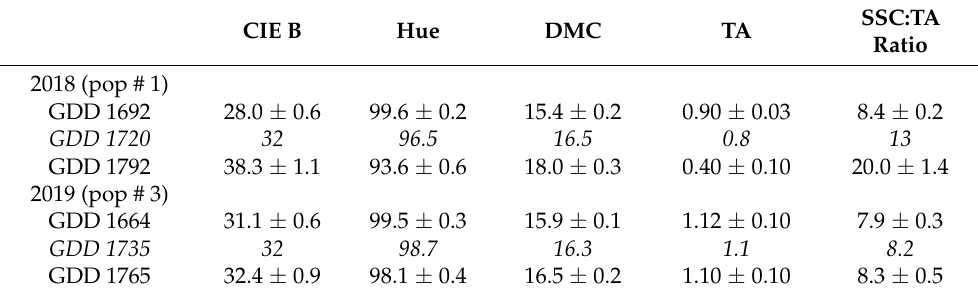
Table 7. Observed values of Calypso fruit attributes at the two harvest dates with CIE B value bracketing the target value of 32 (in italics), and values at the target value, in italics, as estimated by interpolation. GDD are calculated from asparagus stage with Tb = 12 ◦ C, and TB = 32 ◦ C for fruit from the same orchard in 2018 and 2019 seasons. Panicles were tagged on different dates and harvested on one date. Population numbers refer to Table 4. CIE